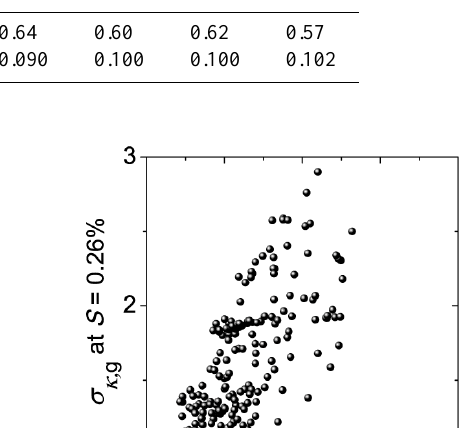
Table 1. Statistics of F in at different diameters (429 data points). F in 30nm 50nm 100nm 150nm 200nm 260nm 320nm Arithmetic mean 0.80 0.74 0.70 0.64 0.60 0.62 0.57 Standard deviation 0.075 0.078 0.084 0.090 0.100 0.100 0.102